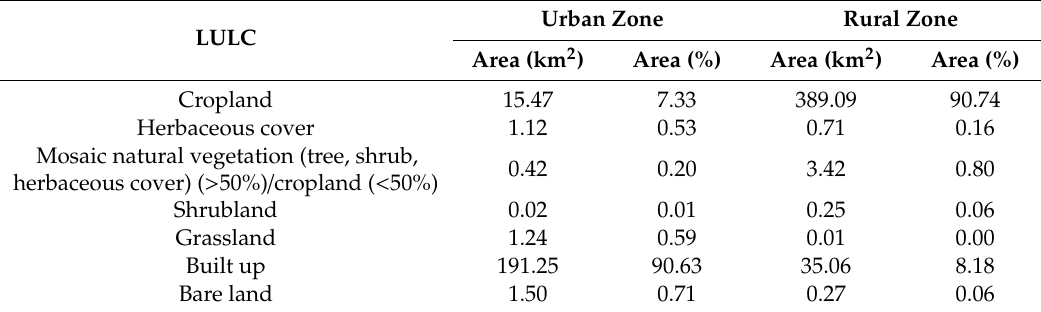
Figure 8. Spatial distribution of LULC classes showing the dominant cropland in the rural area for the year 2003 ( a ) and 2018 ( b ). Panel ( c ) shows the temporal variation of cropland (sum of rainfed and irrigated) and built-up area across the years. Table 2. Mean area over 2003–2018 of the different LULC classes in the urban and surrounding rural zones.